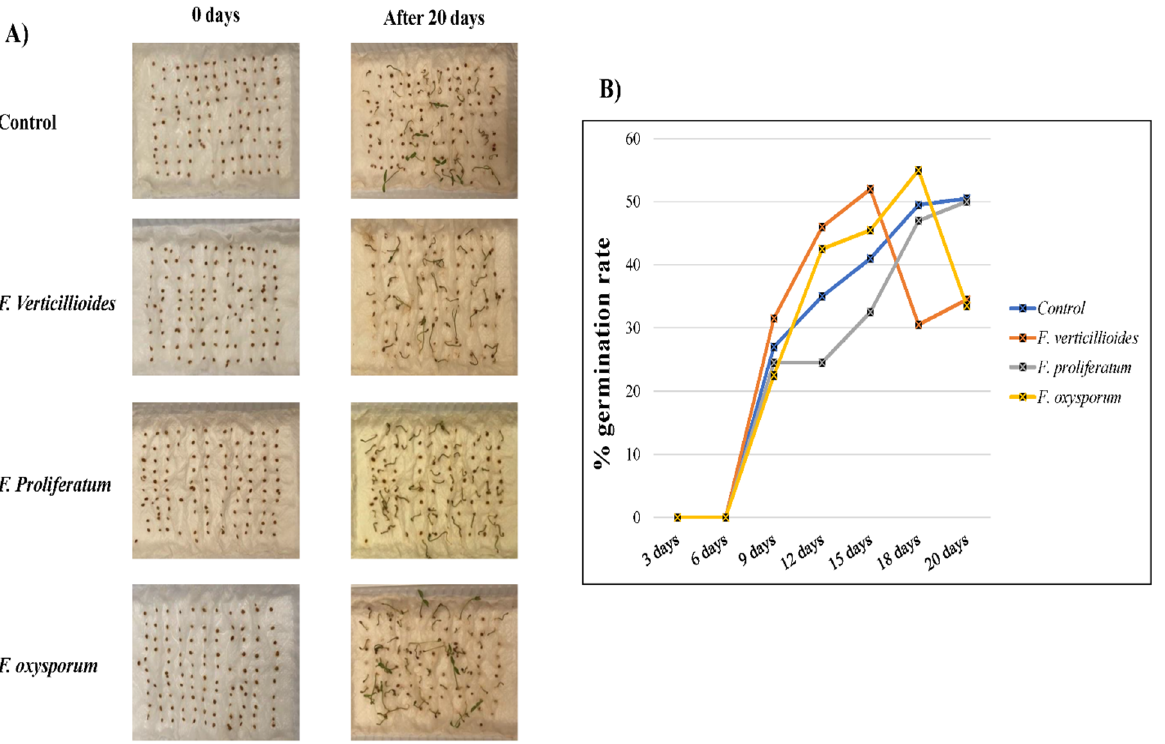
Figure 9. Assessment of toxicity the CFS containing biosurfactants produced by the Fusarium isolates on tomato seeds germination. ( A ) Germination assay of 100 toto seeds in either control settings (water) or treatment (CFSs of Fusarium isolates produced by 1% crude oil, ( B ) percentage of germination rate for 20 days post ‐ treatment.